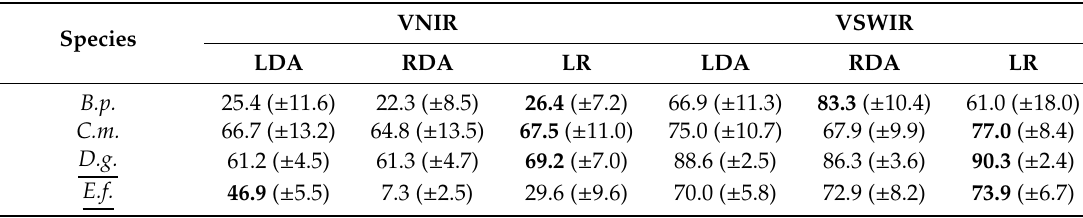
Table 2. Comparison of the F-measure at object level (and standard deviation) obtained after classification with the three methods when either VNIR or VSWIR information are used. Commercial species are underlined. The best prediction for each species with either VNIR or VSWIR information is in